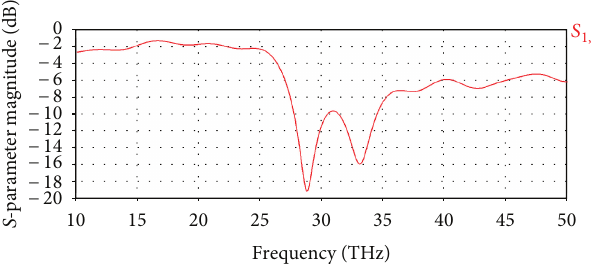
Figure 9: Magnitude of input reflection coefficient for balanced Archimedean spiral